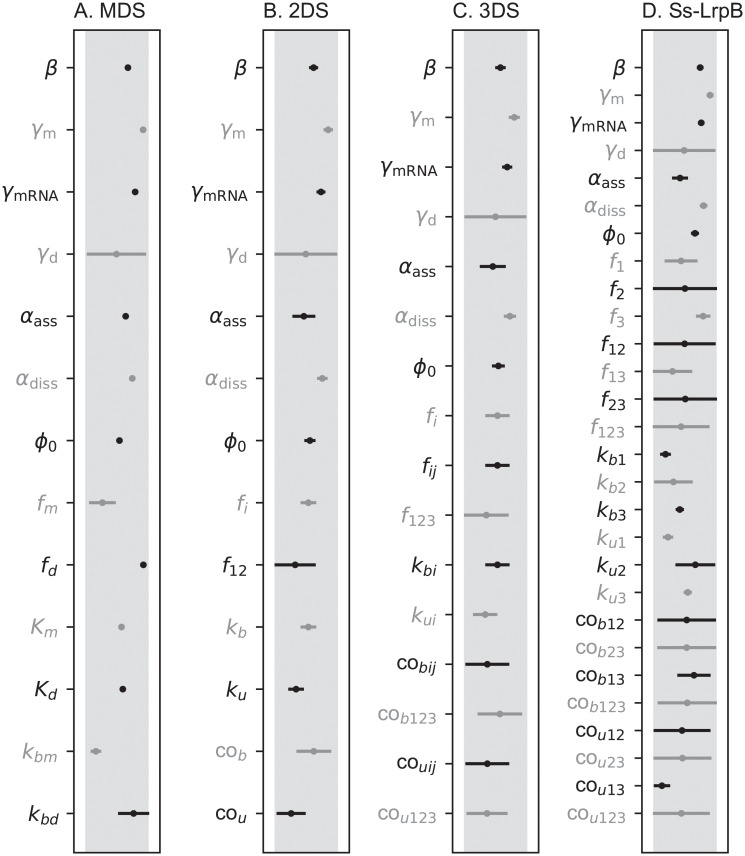
Oscillatory solutions for the different toy models.The shaded region represents the physiological range. The black and gray lines represent the mean oscillatory ranges for the different parameters. The axis is logarithmically scaled, the length of the lines thus represent fold ratios. The line for each parameter is scaled according to the physiological range of this parameter. Ranges are very small for the MDS and become wider for the 2DS and 3DS.